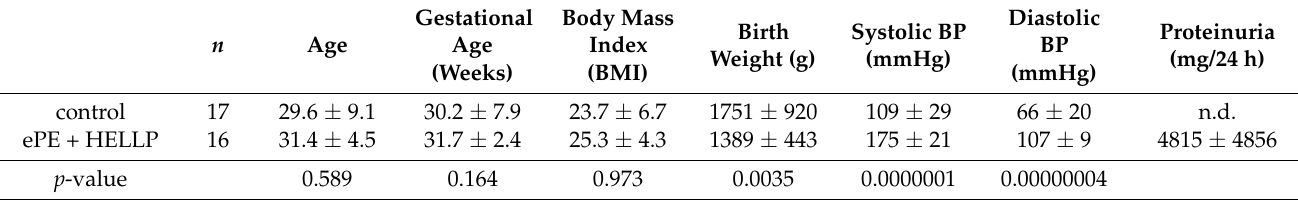
Table 4. Clinical information of patients with early-onset preeclampsia (ePE) complicated by the HELLP (hemolysis, elevated liver enzymes, and low platelet count) syndrome and matched controls. Mean value ± standard deviation is shown. BP, blood pressure; n.d., not